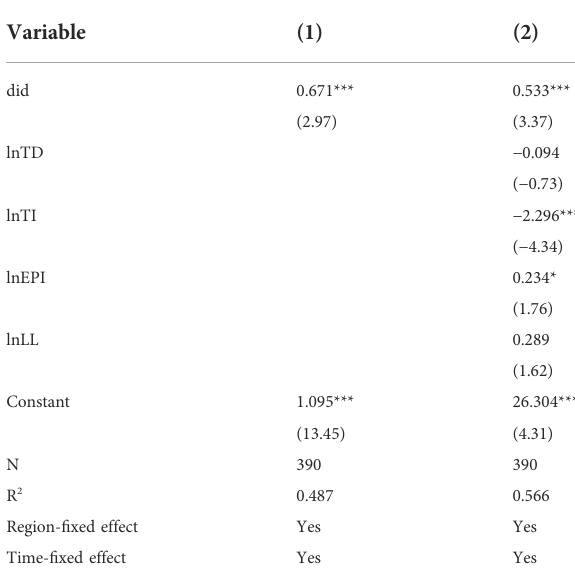
TABLE 2 Regression results of